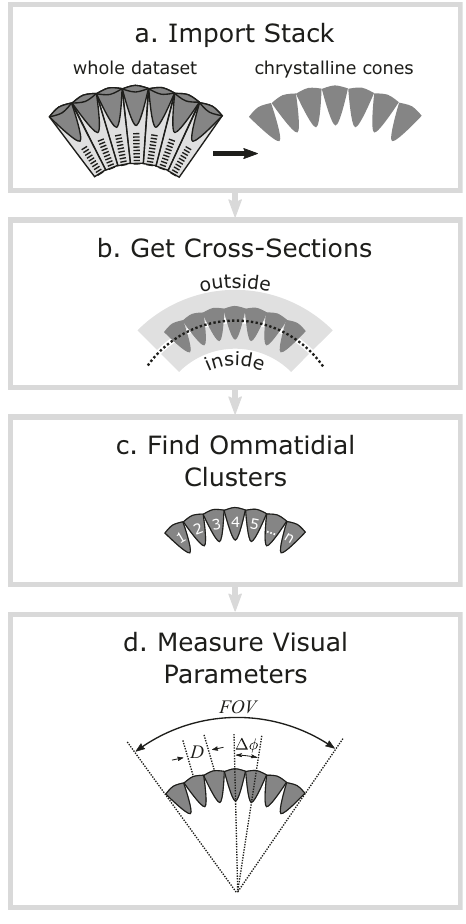
Fig. 5 General steps along the ODA-3D pipeline. a ODA-3D starts with an image stack, which may be pre- fi ltered and cleaned of unrelated structures. b Then we fi lter the relevant density values and fi t a surface to the coordinates, allowing us to split the points into two sets or cross sections, inside and outside the fi tted surface. c For each cross section, we generate spherically projected, rasterized images that are processed by the FFT method for locating ommatidia, yielding approximate centers for the ommatidia. With these centers, we can fi nd the coordinate clusters corresponding to independent ommatidia d These can then be used to automatically measure eye program stores ommatidia coordinates and calculates ommatidial diameter. An optional imported mask (a white silhouette on a black background) can help avoid false positives outside of the eye.